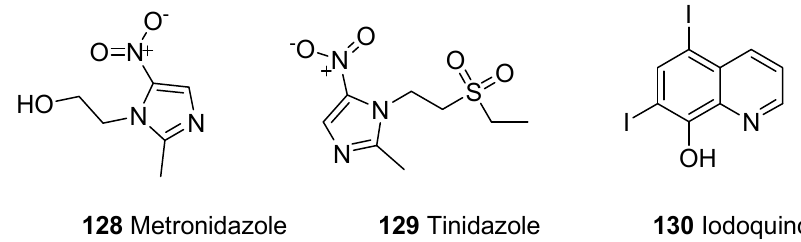
Figure 22. Amoebicidal commercial dugs 128–130 .